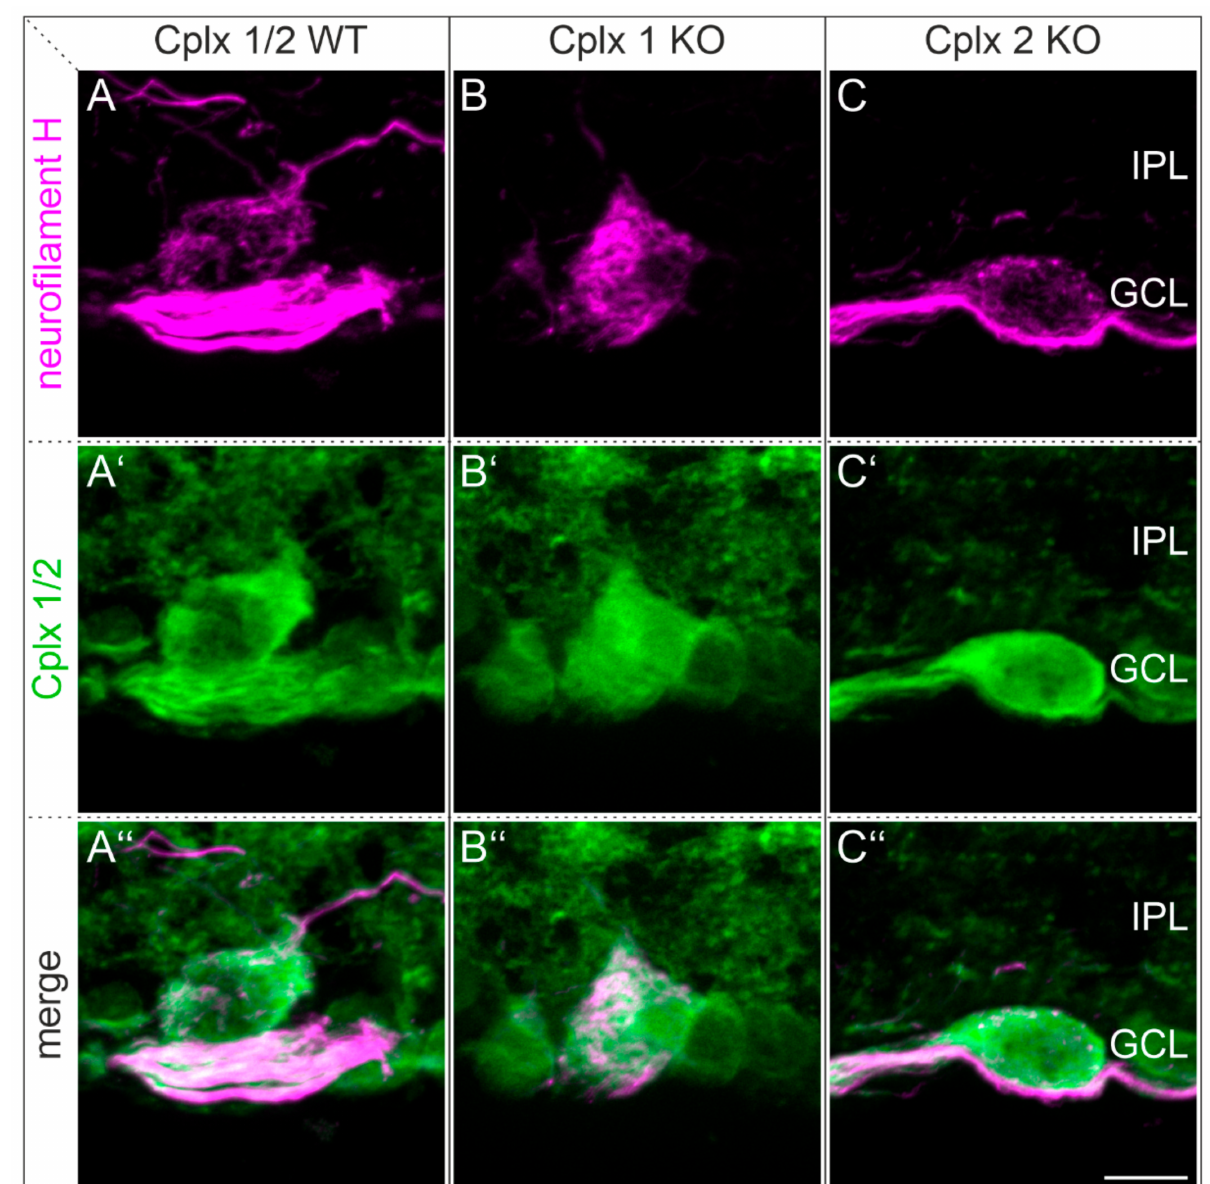
Figure 9. Expression of Cplx 1/2 in alpha ganglion cells in mouse retina. ( A – C (cid:48)(cid:48) ) Fluorescence micrographs of vertical cryostat sections through retinae of wildtype (WT) and Cplx 1 and Cplx 2 knockout (KO) mice double labeled with antibodies against neurofilament H (alpha ganglion cells) and Cplx 1/2. IPL, inner plexiform layer; GCL, ganglion cell layer. Scale bar = 10 µ m in ( C (cid:48)(cid:48) ) for ( A – C (cid:48)(cid:48)